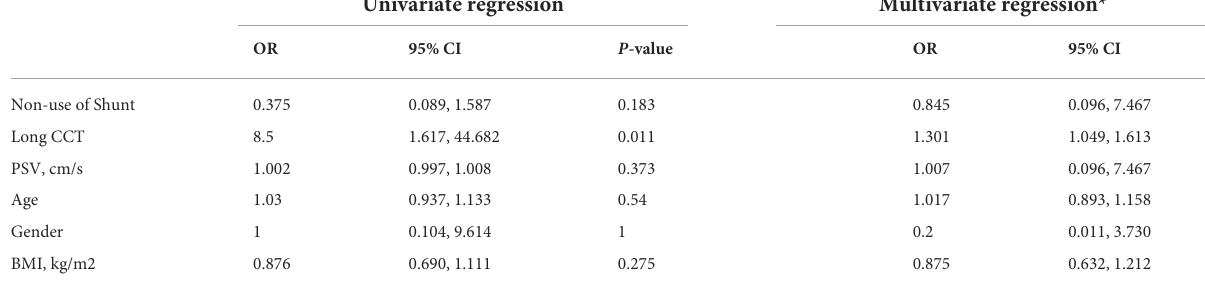
TABLE 3 Association of peri-operative measurements with adverse event. Univariate